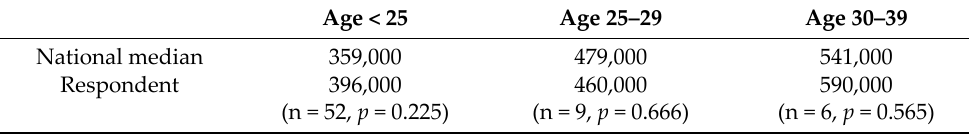
Table 4. Annual income by age